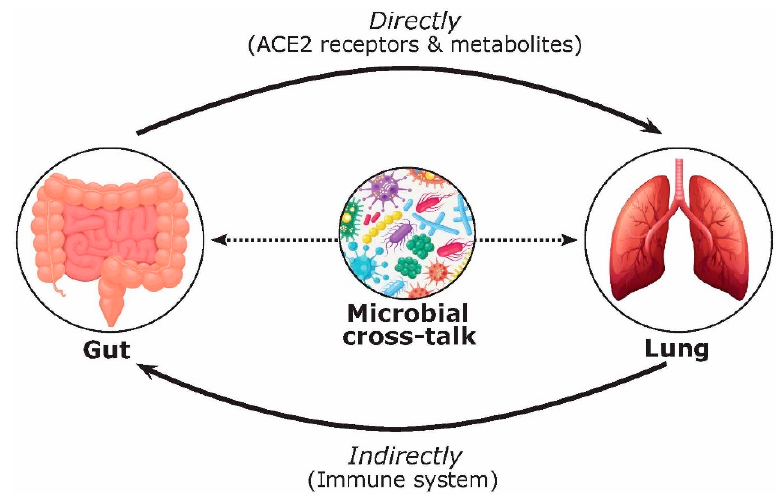
Figure 2. Multifaceted mechanisms involved in the gut–lung axis during COVID-19 infection affecting FMT safety and efficacy. The bidirectional effects of the gut–lung axis are complex and can take place via direct (i.e., ACE2 receptors and metabolites including short chain fatty acids (SCFAs) and bile acids) and indirect (i.e., immune system) mechanisms.